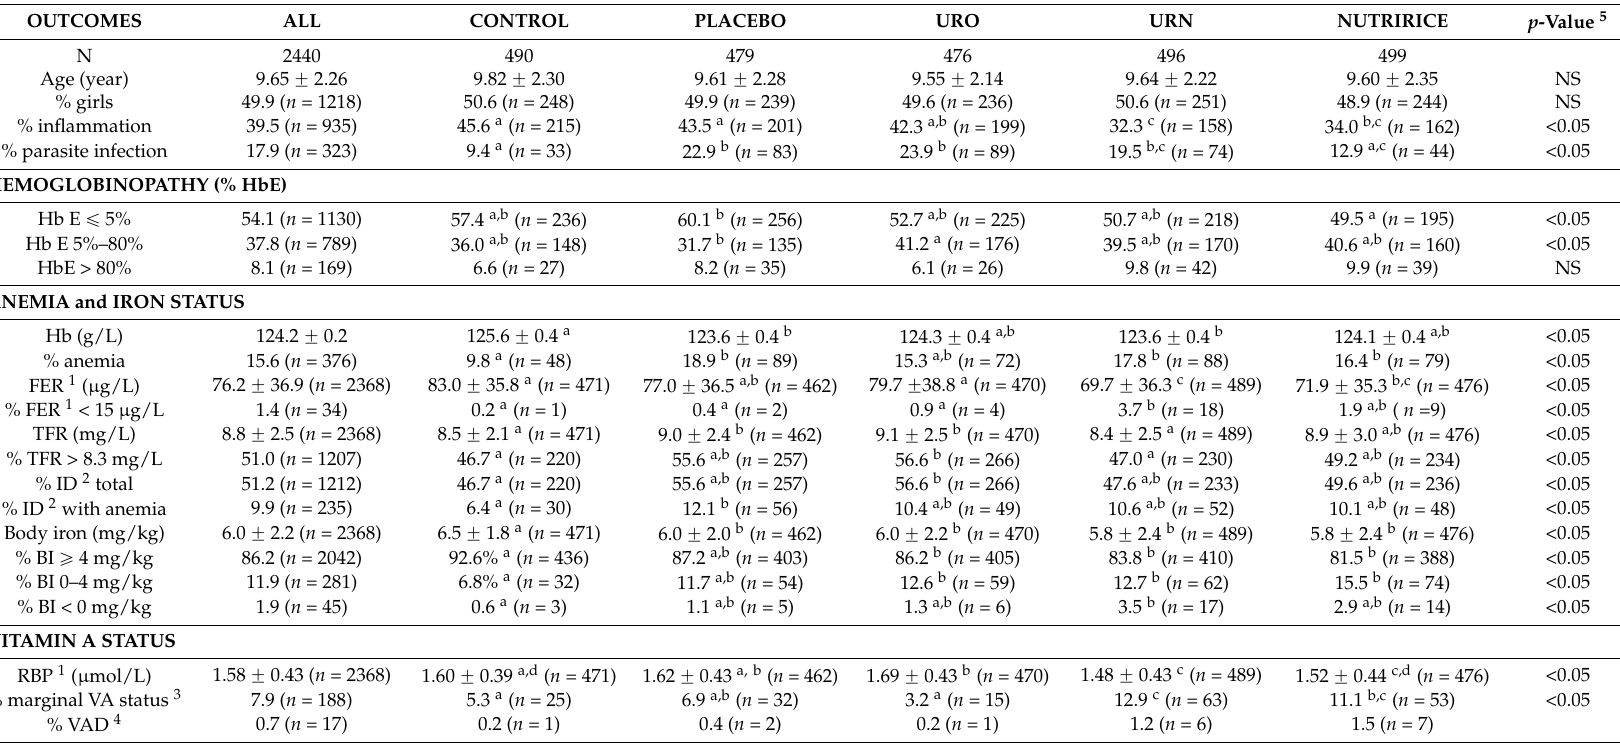
Table 2. Baseline characteristics of all children participating in the study and for each intervention